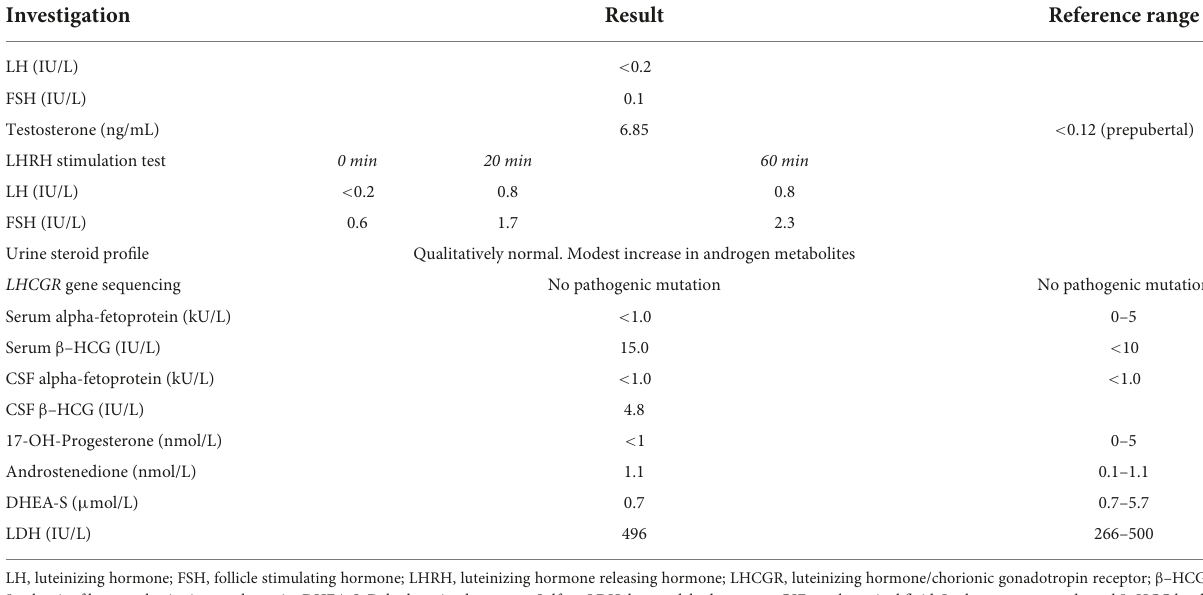
TABLE 1 Results of baseline laboratory investigations.